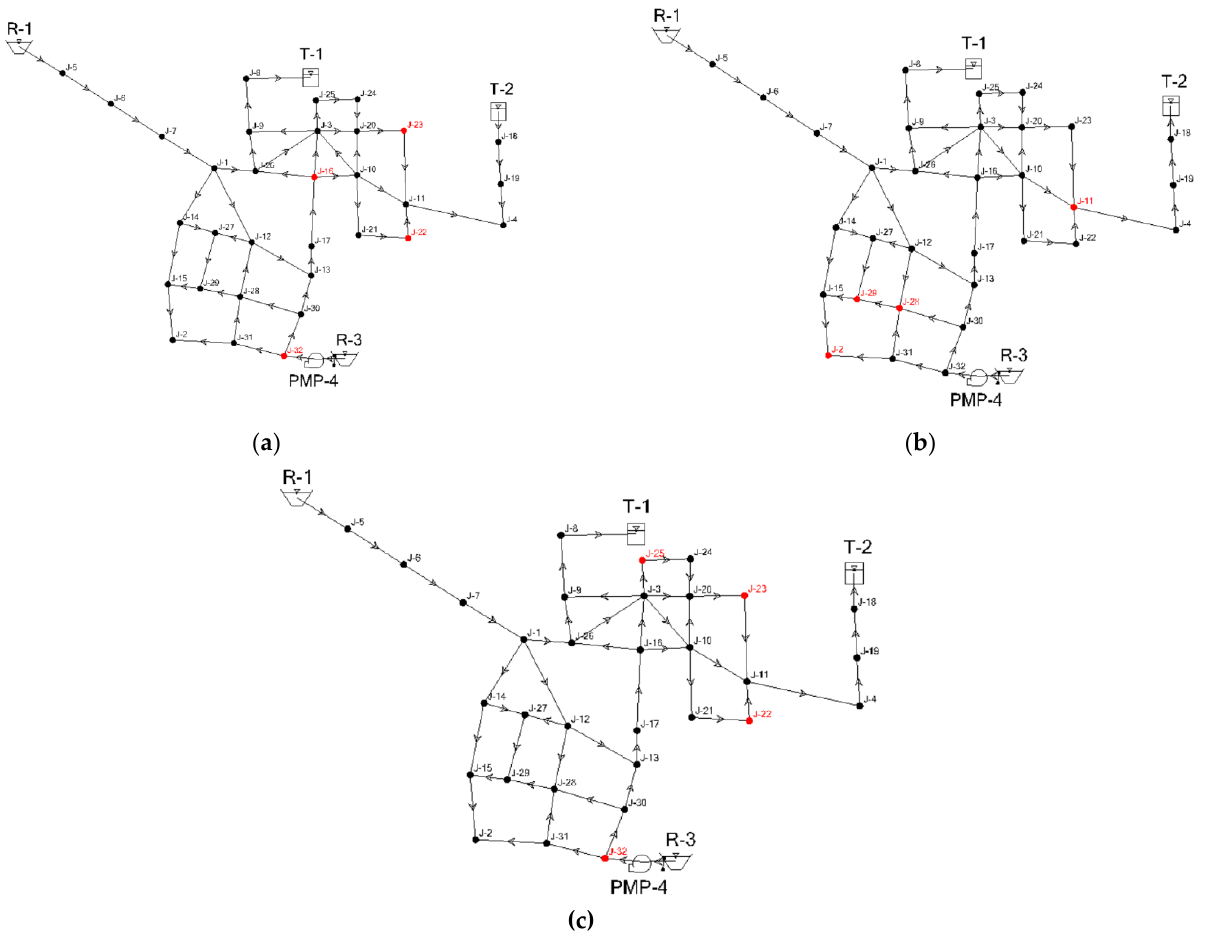
Figure 1. The nodes (marked as red) with: ( a ) the lowest values for objectives O 1 , O 2 and O; ( b ) the highest values for the objective O 3 ; and ( c ) the lowest values for the objective O 4 . Table 2. The four nodes with the lowest values for objectives O 1 , O 2 , O 4 and O and the highest values for objective O 3